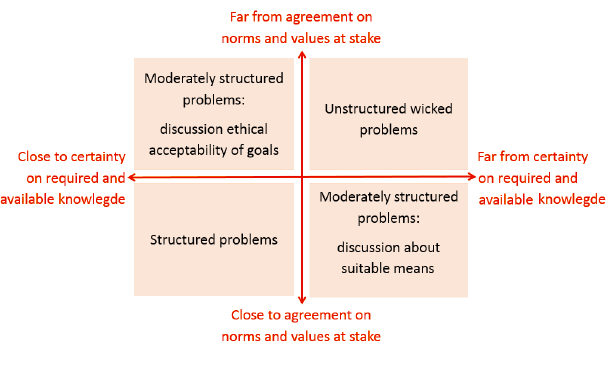
Fig. 1. Characteristics of structured, moderately structured, and unstructured